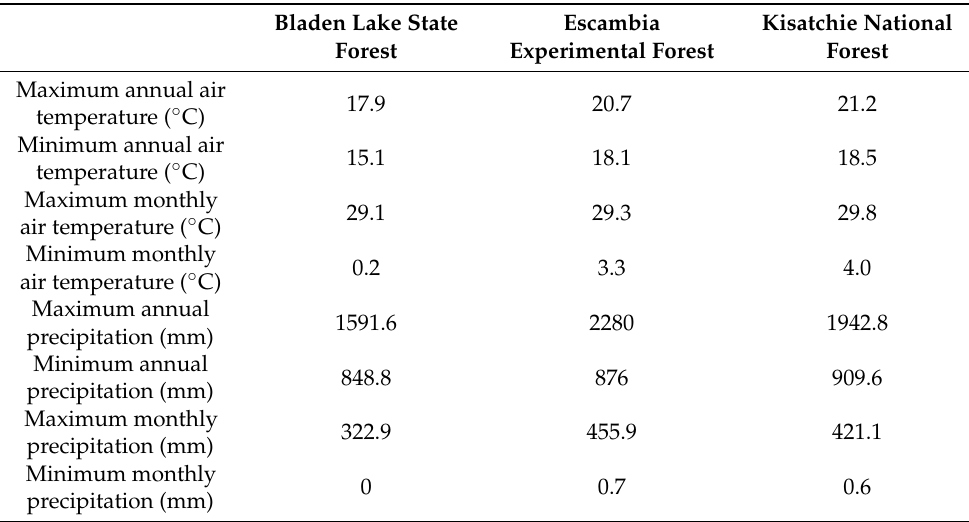
Figure 4. The variation in annual air temperature and the average of every 10 years at the 3 sites from 1901 to 2020. Table 1. The maximum and minimum air temperatures and precipitations occurred at the three sites from 1901 to 2020.